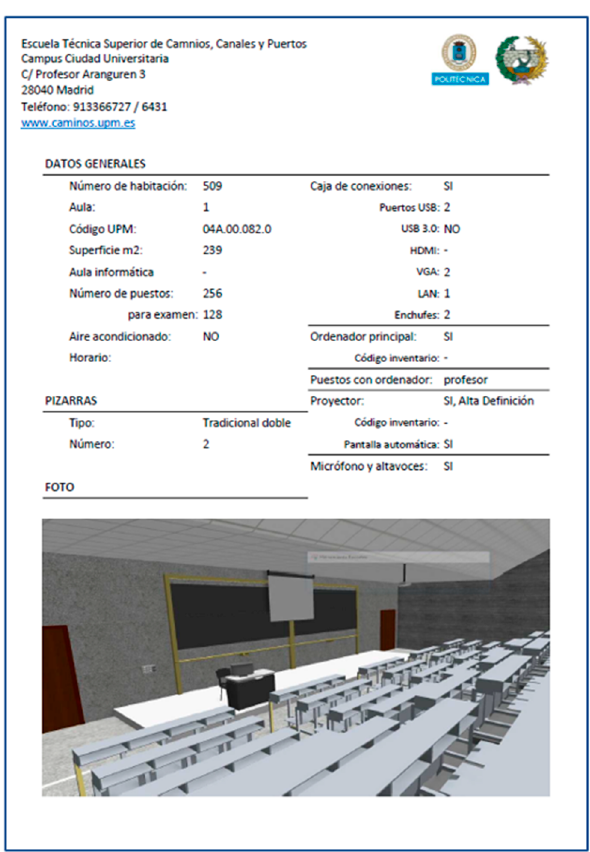
Figure 8. Room sheet.